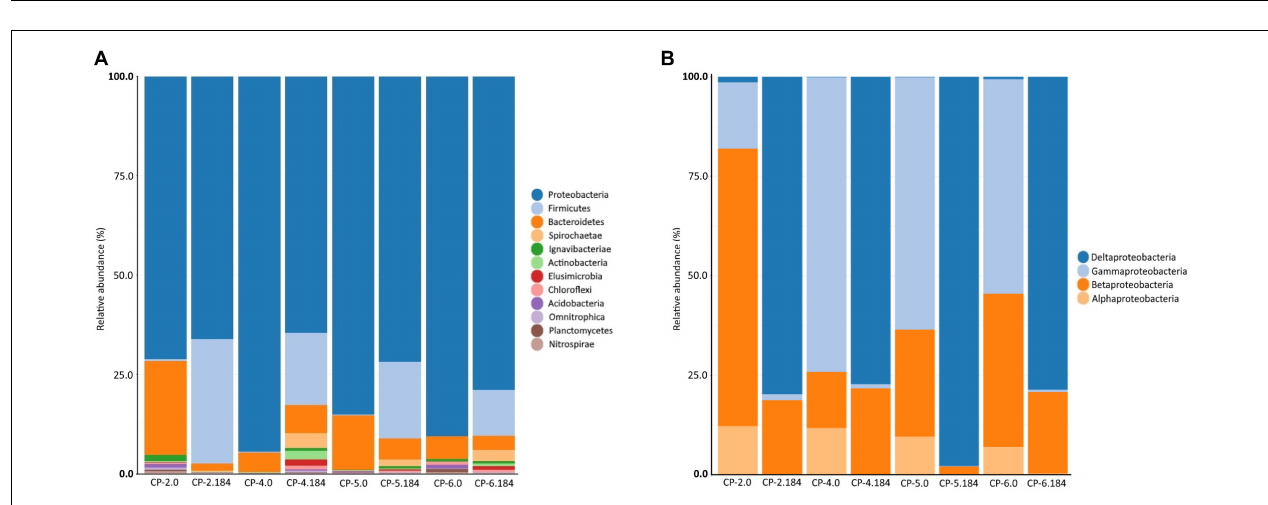
FIGURE 10 | Phyla abundance (A) and Proteobacteria class abundance (B) , in the samples of Nitrastur groundwater from CP-2, CP-4, CP-5 and CP-6 monitoring wells before the treatment (0) and at the end of the treatment (184